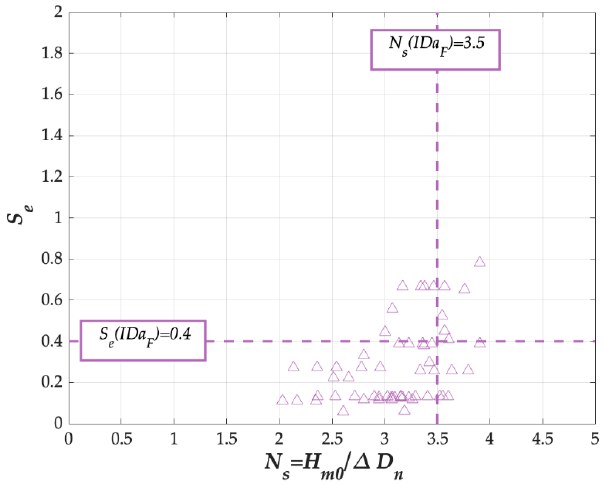
Figure 11. Armor damage to the front slope of the Cubipod ® -armored model and IDa level.